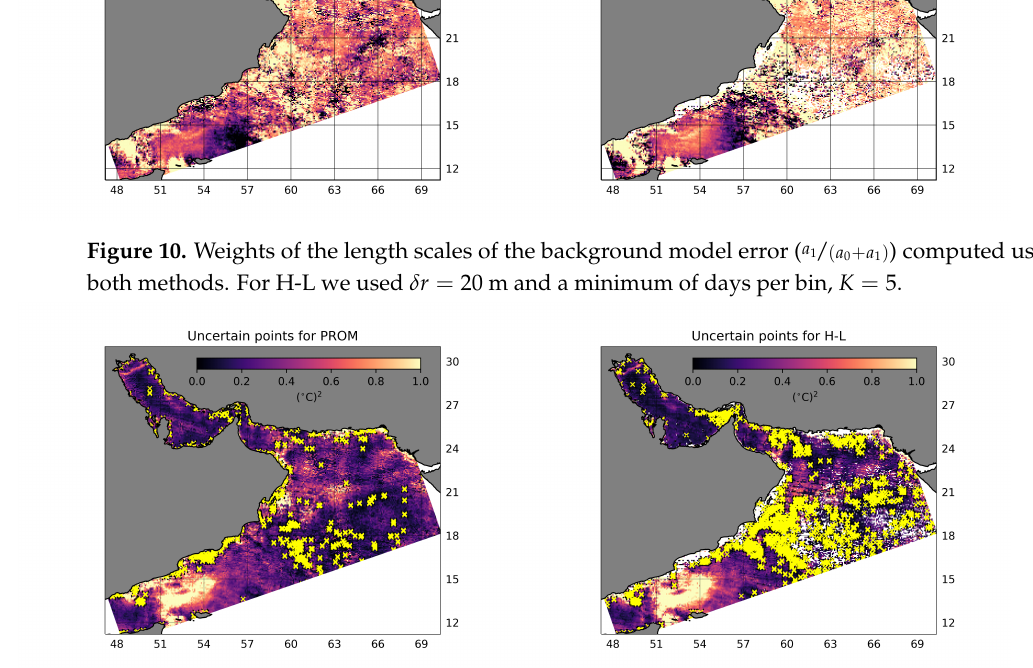
Figure 11. Points that do not satisfy the inequality in Equation (25) for horizontally adjacent valid grid nodes. In the left plot are the 779 uncertain points found for the PROM method, in the right, the 1622 uncertain points found for H-L with a bin size of 20 km and a minimum number of days per bin K =